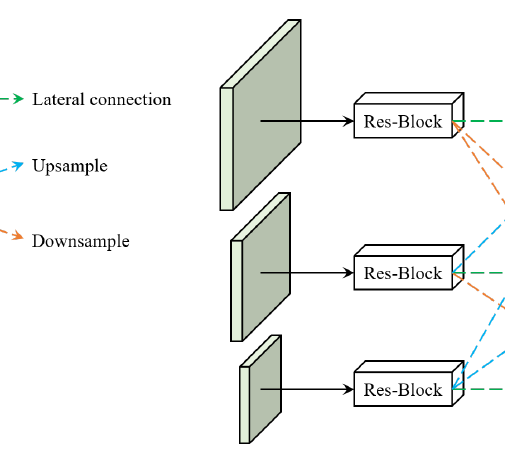
Figure 11. The architecture of the nonlinear transformation G θ . The dash lines denotes pyramid convolution to reduce the computation redundancy and efficiently fuse cross-scale